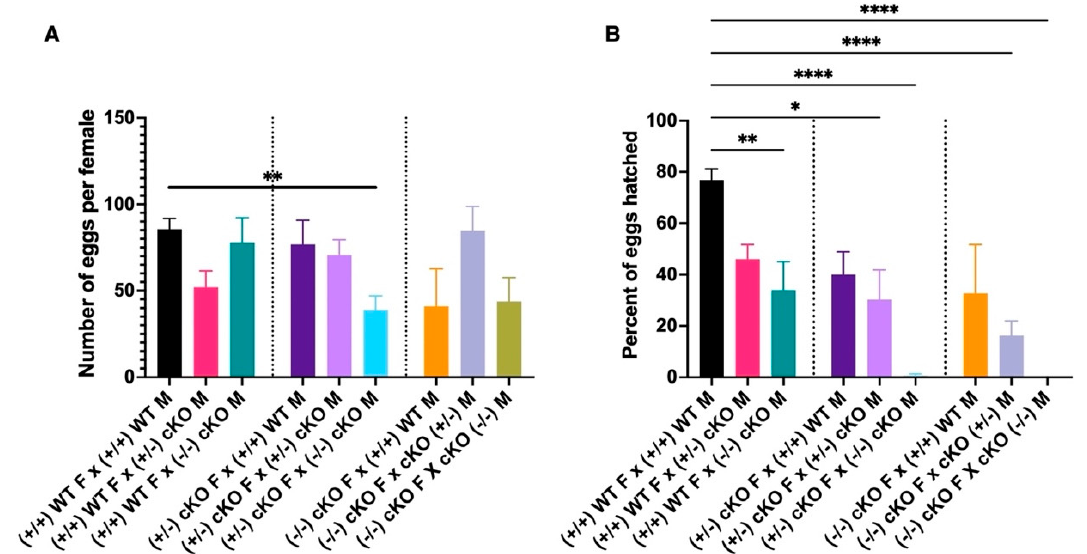
Figure 7. ( A ) Number of eggs laid per female for various crosses of the CRVP-cKO line. M = male, F = female. ( B ) Percentage of eggs hatched from various crosses of CRVP-cKO. Statistically significant p values are depicted with an asterisk (*); * = p < 0.05, ** = p < 0.007, **** = p < 0.0001, (Dunn’s multiple comparisons test), error bars represent standard error of mean. WT Liverpool +/+, CRVP379-cKO heterozygous genotype +/ − , CRVP379-cKO homozygous genotype − / − .